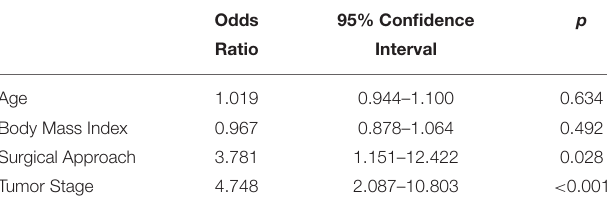
TABLE 3 | Multivariate analysis for predictors of urothelial carcinoma recurrence in UTUC who underwent